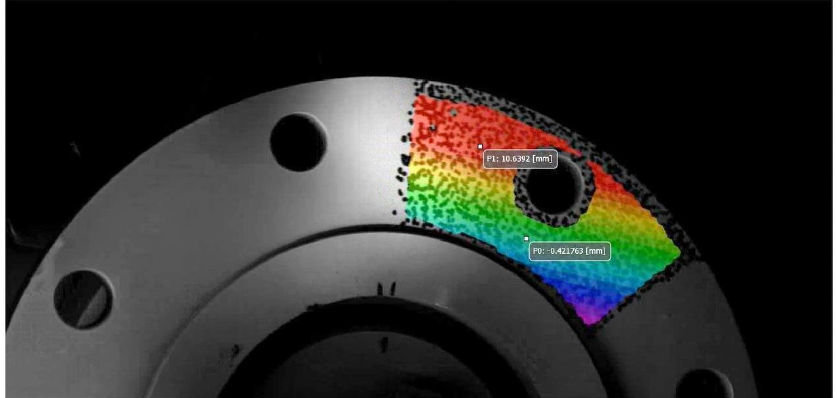
Figure 19. Diagram of variation of the linear displacement u 0 and of the corresponding torsion angle Φ for the case of the solitary operation of the right motor.